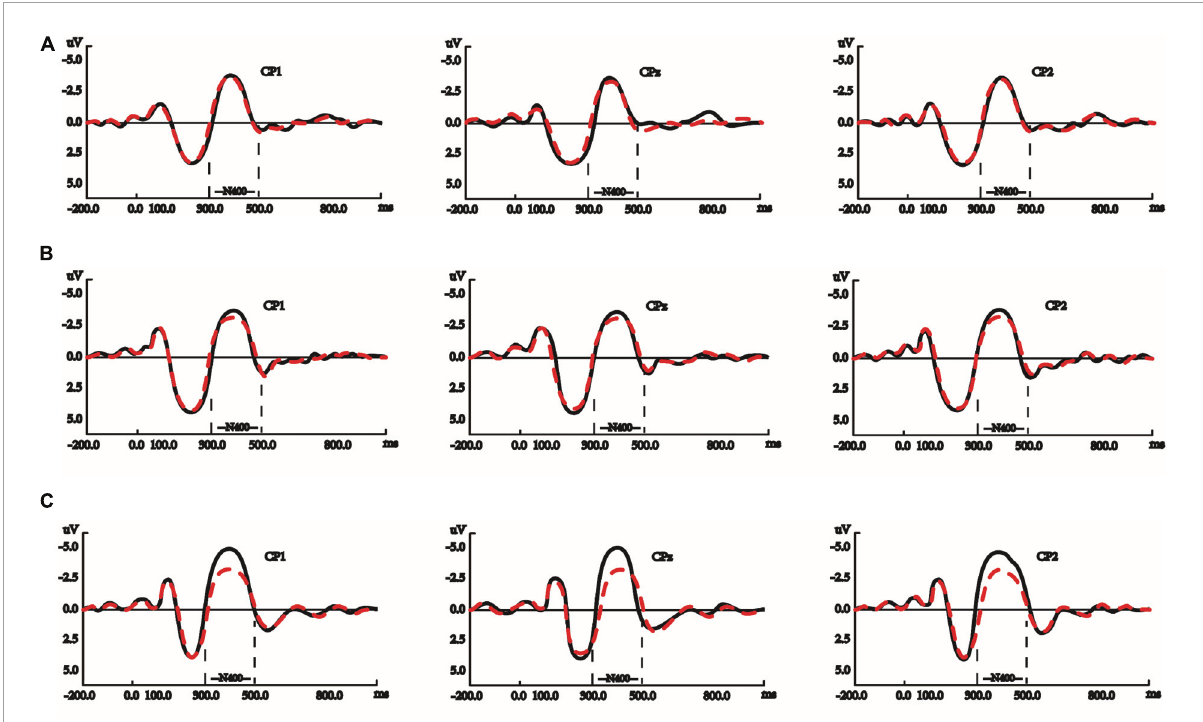
FIGURE5 (A) Native signers with low L2Level did not possess significantly dissociated N400 effect between processing noun (red dashed lines) and verb (black solid lines) in written Chinese sentences. The y-axes in these panels are negative up. (B) Native signers with mid L2Level did not possess significantly dissociated N400 effect between processing noun (red dashed lines) and verb (black solid lines) in written Chinese sentences. The y-axes in these panels are negative up. (C) Native signers with mid L2Level possessed significantly dissociated N400 effect between processing noun (red dashed lines) and verb (black solid lines) in written Chinese sentences. The y-axes in these panels are negative